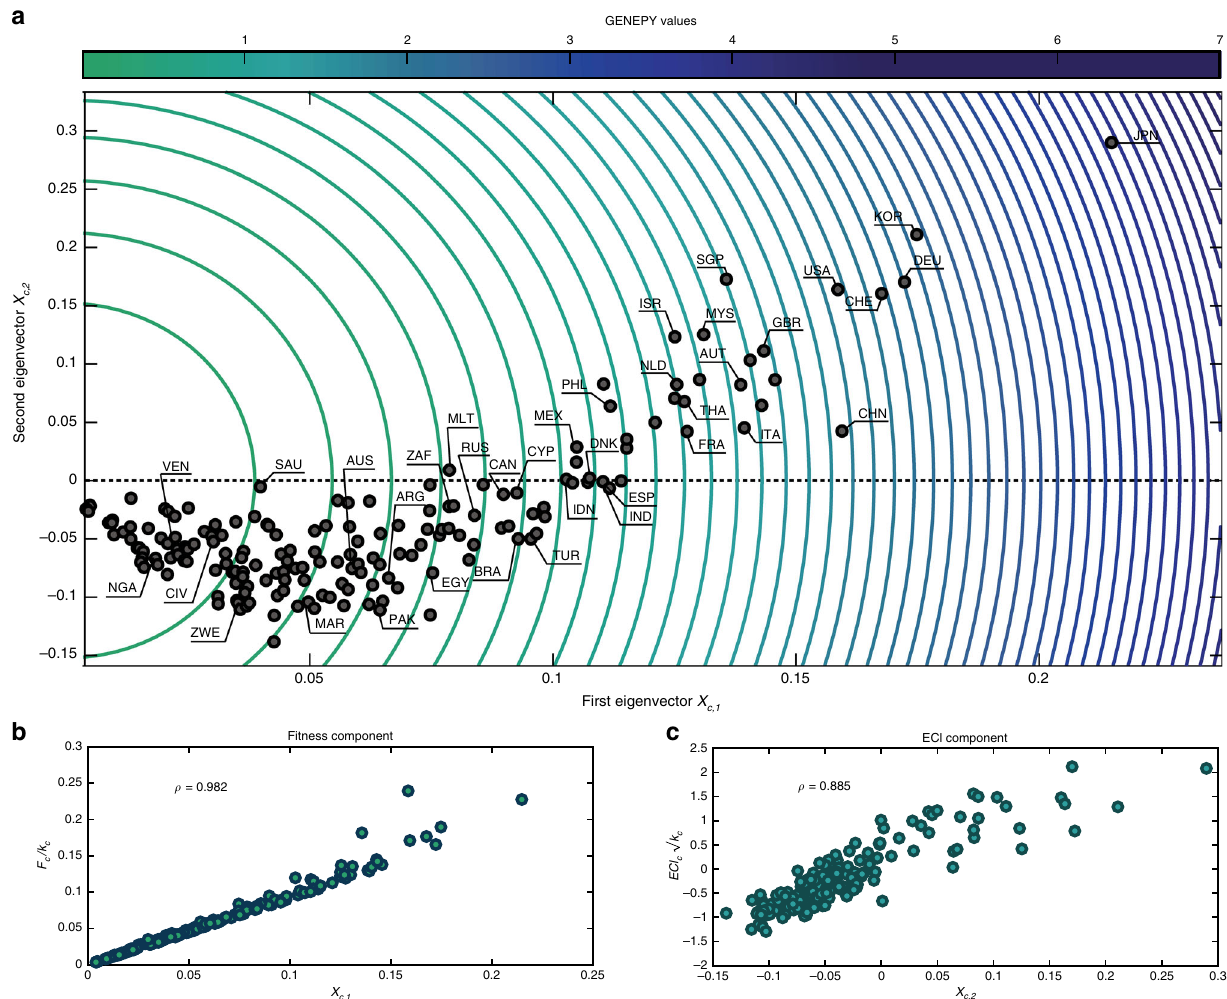
Fig. 1 The GENEPY index and its components. a { X c ,1 , X c ,2 } plane and GENEPY c from the data of 2017 international products' trade. The x-axis reports the components of the fi rst eigenvector X c ,1 , whilst the y-axis the components of the second eigenvector X c ,2 . The eigenvectors are normalised such that their P P X 2 ¼ X 2 ¼ 1. Contours range from lower GENEPY c values (green) to higher ones (blue). b Fitness component. Frobenius norm is unitary, i.e., c ; 1 c ; 2 c c Scatter plot of the fi rst component X c ,1 compared with the values of the Fitness values F c rescaled by the countries degree k c (see Methods section, Eq. (14)). c ECI component. Scatter plot of the second component X c ,2 compared with ECI c values rescaled by the term